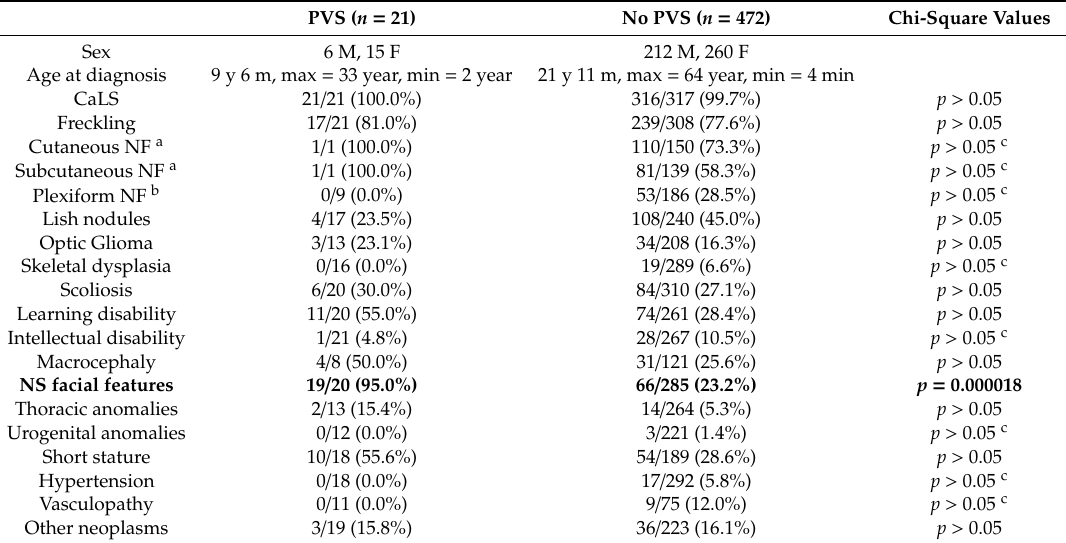
Table 4. Prevalence of non-cardiac phenotypic characteristics in NF1 patients of present series, with and without